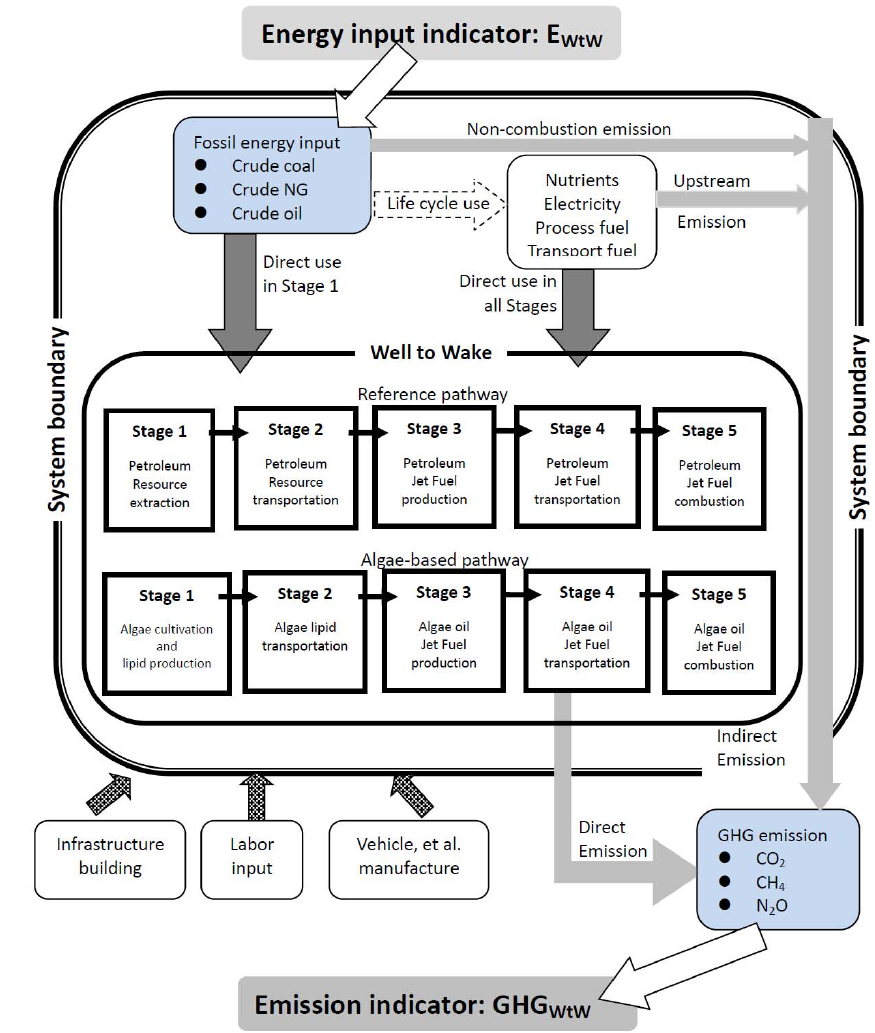
Figure 1. Stages covered and system boundary in this